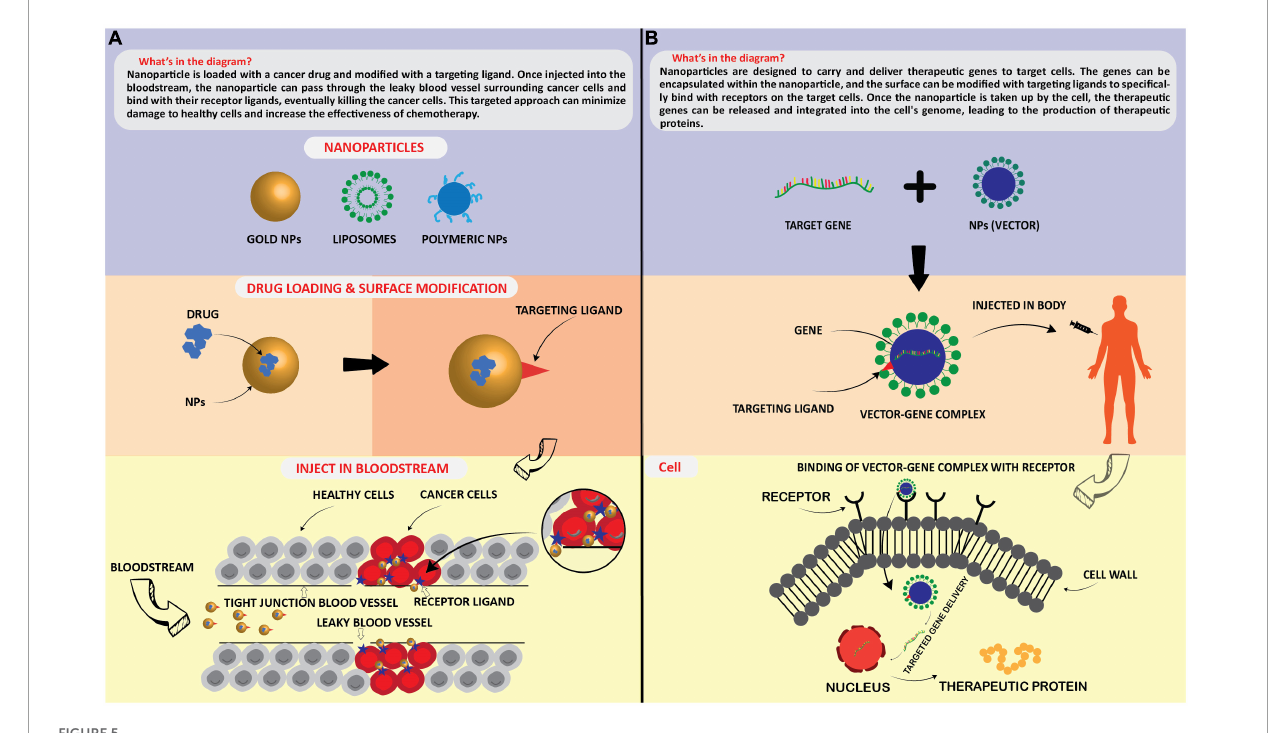
FIGURE5 Application of nanoparticles as; targated drug delivery (A) , and therapeutic protein generation in targated cells (B)